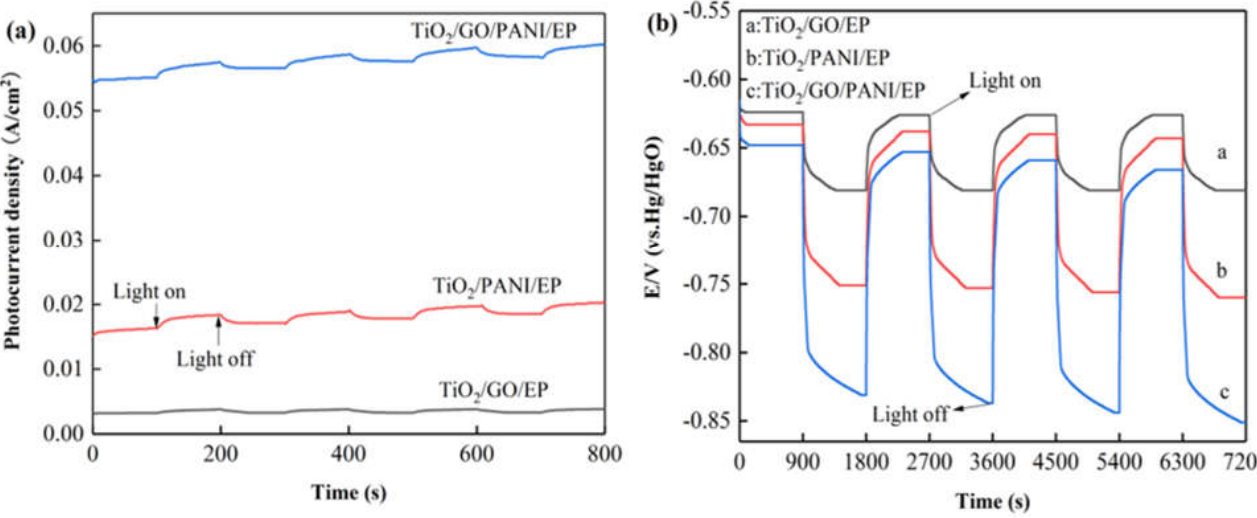
Figure 4. ( a ) I-t curve (vs. Hg/HgO) ( b ) OCP-t curves (vs. Hg/HgO) of the Q235 coated with TiO 2/ GO/EP, TiO 2 /PANI/EP, and TiO 2 /GO/PANI/EP coating under intermittent light on and off.